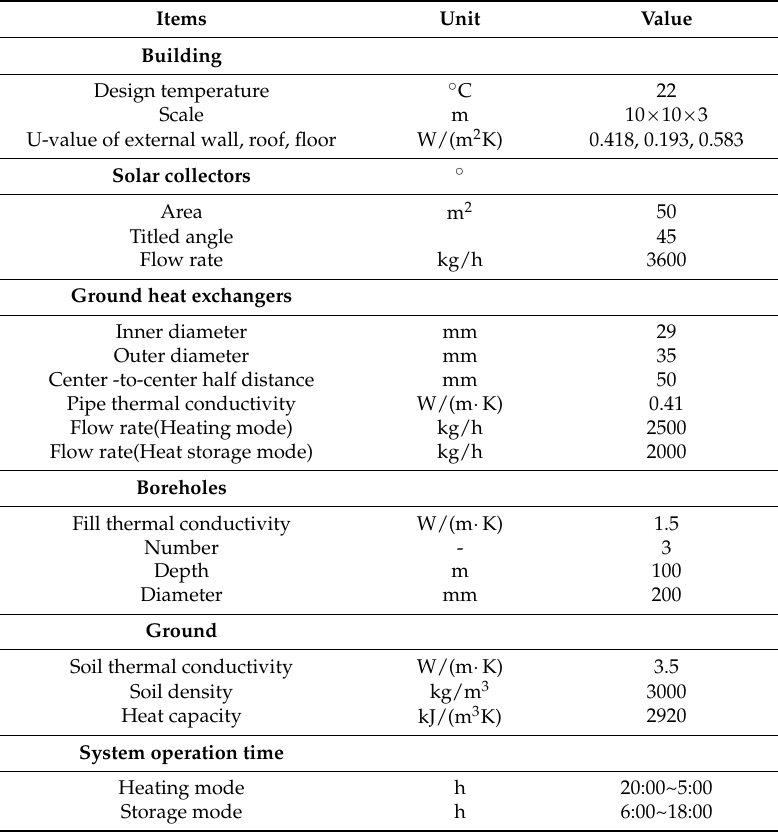
Table 1. Basic simulation